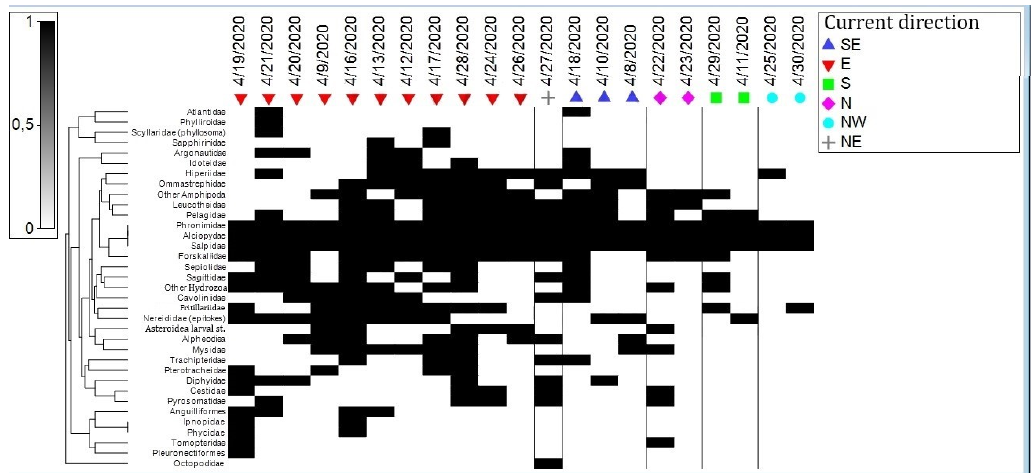
Figure 4. Dendogram plot performed by Primer v7 combined with the shadow plot for the presence (from 0 to 1) in the monitored time and the daily current direction.